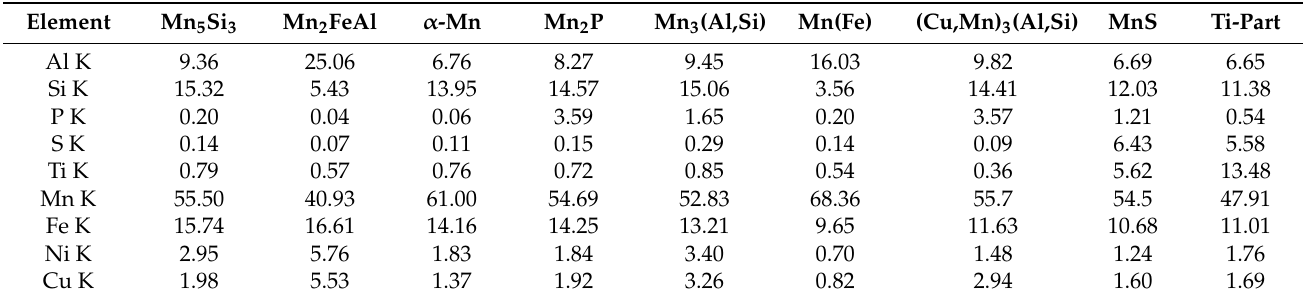
Table 5. Composition of phases in sample with 20% excess aluminum measured by EDS. Measured compositions from areas investigated by EBSD are given. Error of measurement depends on number of counts in peak.